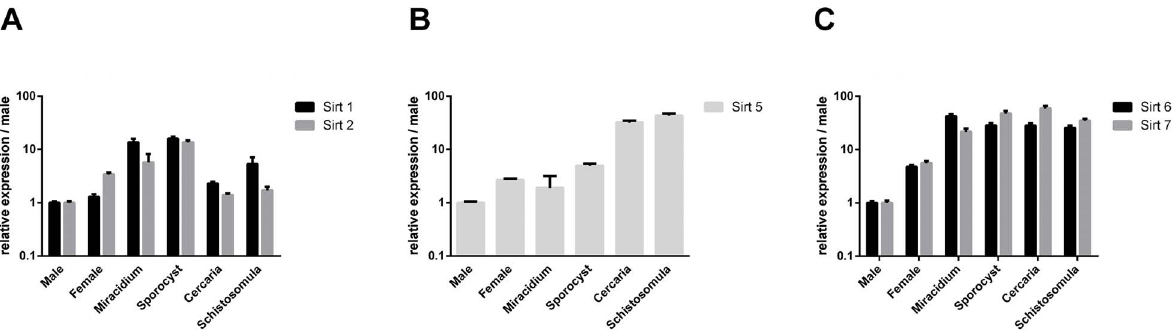
Figure 3. Quantitative of transcripts class I sirtuins (Figure 3 A), class III (Figure 3 B) and class IV (Figure 3C) at different S.mansoni life cycle stages. SmSirt1 , 2 , 5 , 6 and 7 mRNA was measured in male and female adult worms, miracidia, sporocysts, cercariae and schistosomula by quantitative real-time PCR. S. mansoni a -tubulin was used as reference gene. Results are expressed as the log of 2 2 DD Ct ratio compared to the expression in male worms taken arbitrarily as the base line.